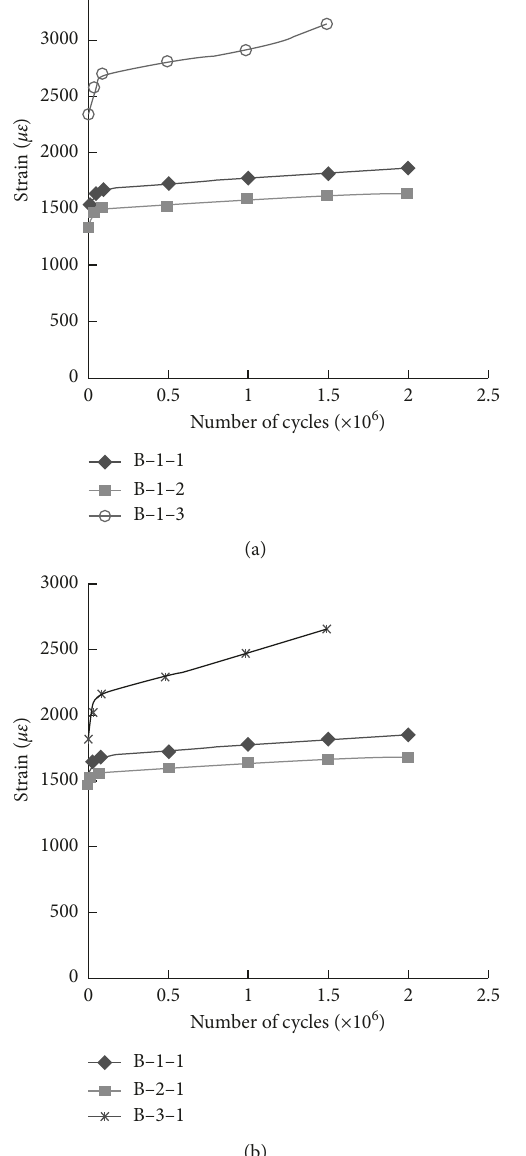
Figure 4: Reinforcement strain-cycle number curves.